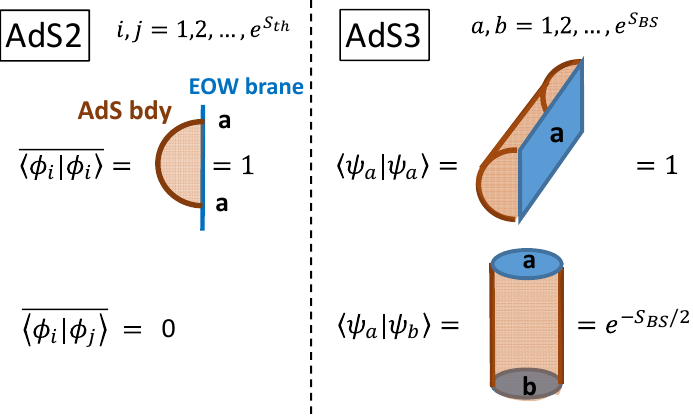
Figure 3 . Gravity evaluations of the inner products of microstates h φ i | φ j i in AdS 2 gravity (left) and those of regularized boundary states h ψ a | ψ b i in AdS 3 gravity